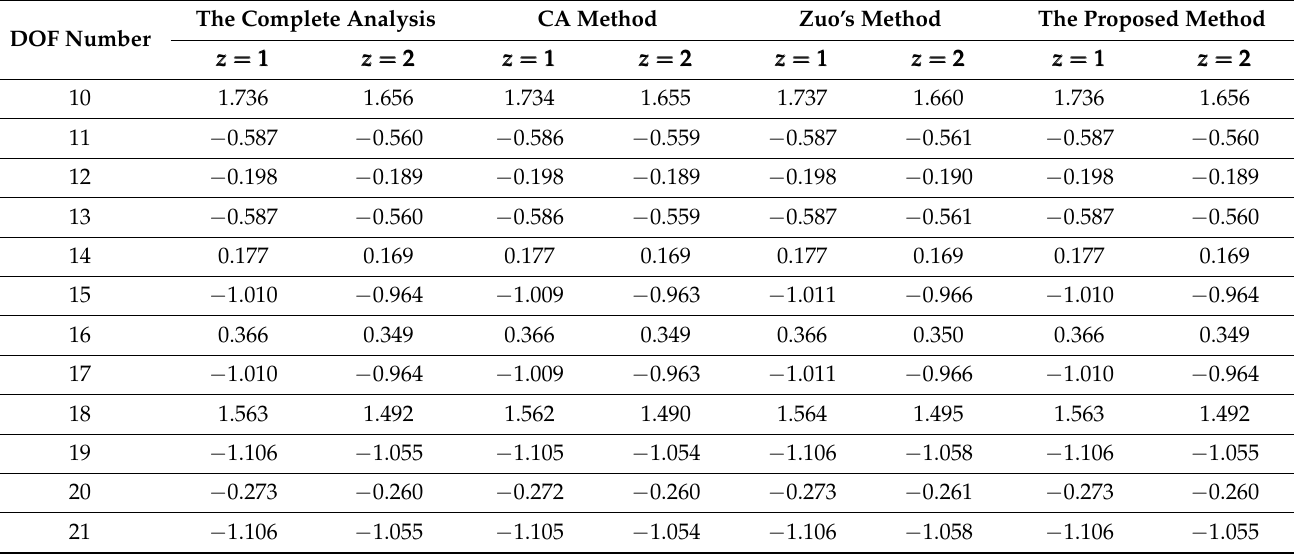
Table 10. Displacement sensitivities for modification type 3 when z = 1 and z = 2 ( × 10 − 5 ).